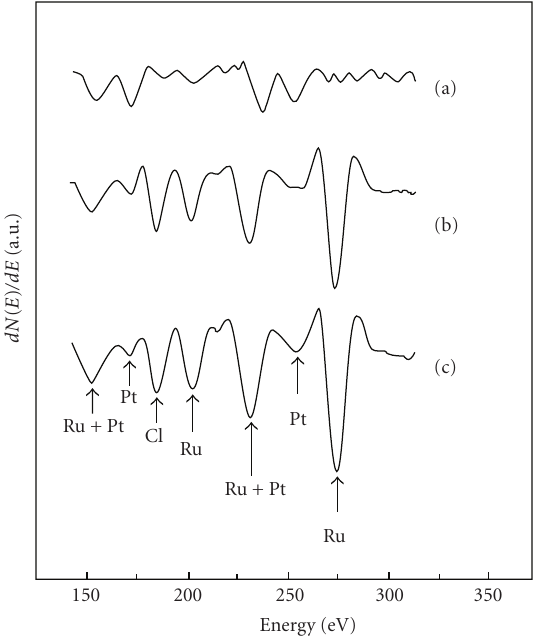
Figure 5: Auger electron spectra of the pure Pt(111) (a) and Ru- modified Pt(111) electrodes with 0.64 (b) and ∼ 1ML Ru coverage